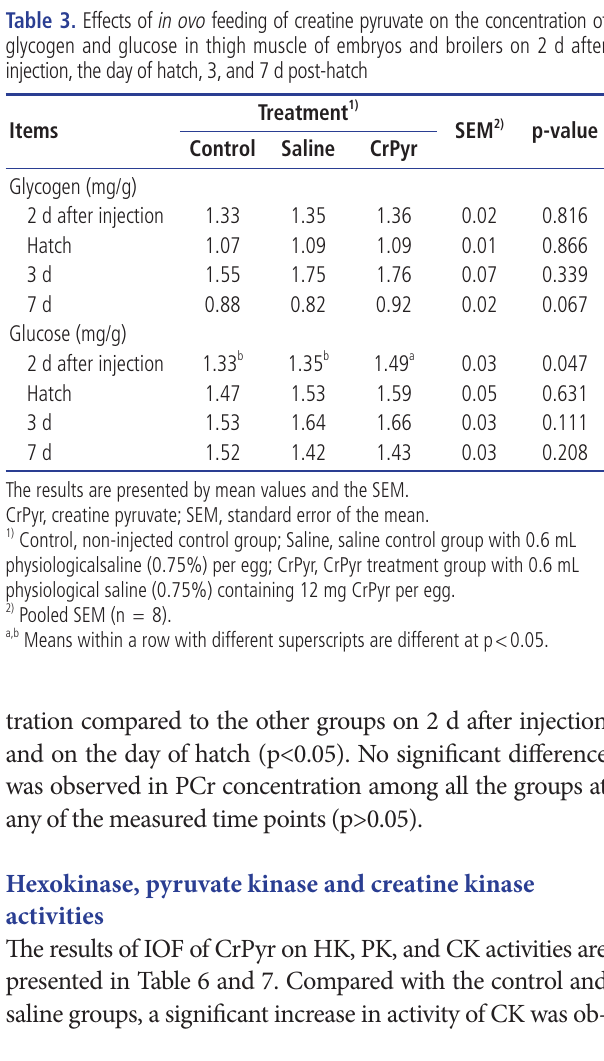
Table 4. Effects of in ovo feeding of creatine pyruvate on the concentration of pyruvate and lactic acid in thigh muscle of embryos and broilers on 2 d after injection, the day of hatch, 3, and 7 d post-hatch